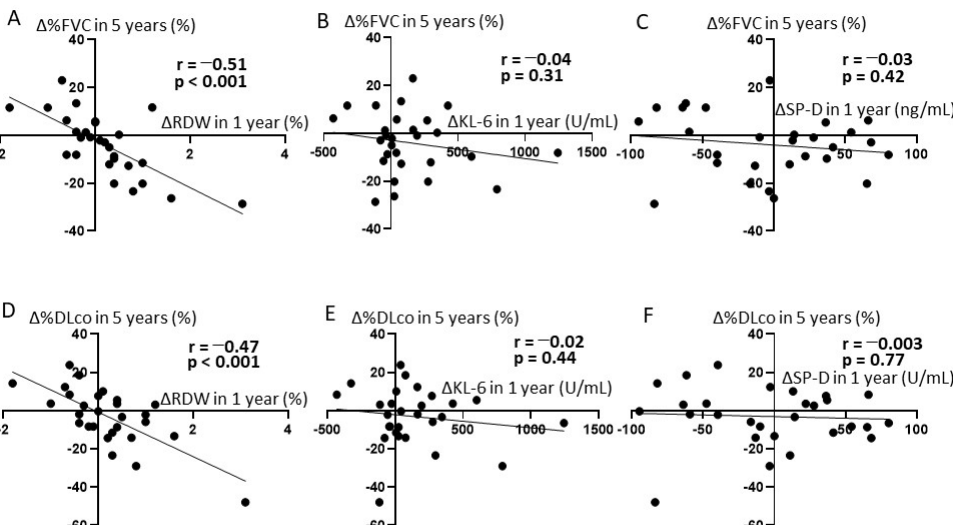
Figure 1. Correlation of peripheral blood markers with the absolute changes in %FVC and %DLco in SSc-ILD patients. ( A ) The absolute change of RDW at year 1 vs. absolute change in %FVC at year 5. ( B ) The absolute change of KL-6 at year 1 vs. absolute change in %FVC at year 5. ( C ) The absolute change of SP-D at year 1 vs. absolute change in %FVC at year 5. ( D ) The absolute change of RDW at year 1 vs. absolute change in %DLco at year 5. ( E ) The absolute change of KL-6 at year 1 vs. absolute change in %DLco at year 5. ( F ) The absolute change of SP-D at year 1 vs. absolute change in %DLco at year 5.